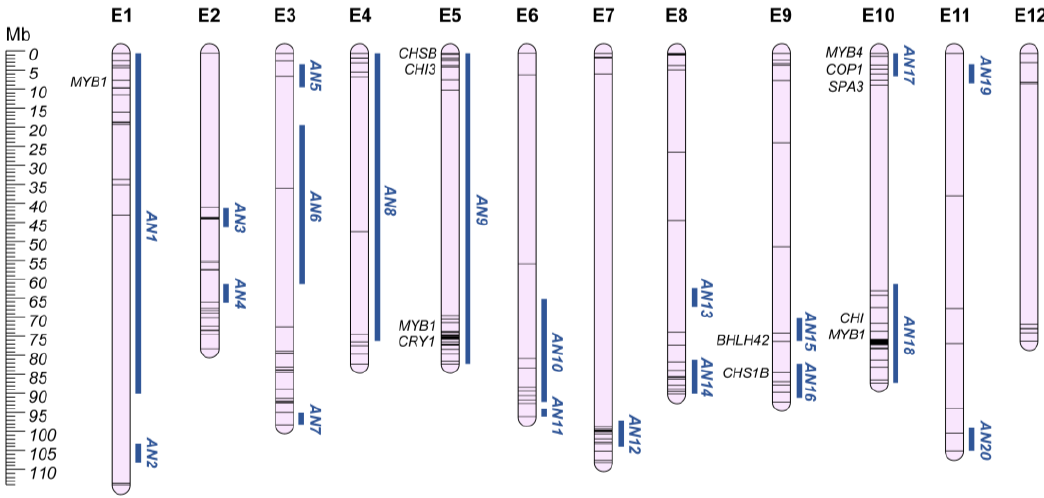
Figure 5. Anthocyanins QGRs (AN; Blue) chromosome map (E1 – E12). Main candidate genes are reported in italics, while information about the other candidates (represented by bars on the chromosomes) are shown in Table S3.